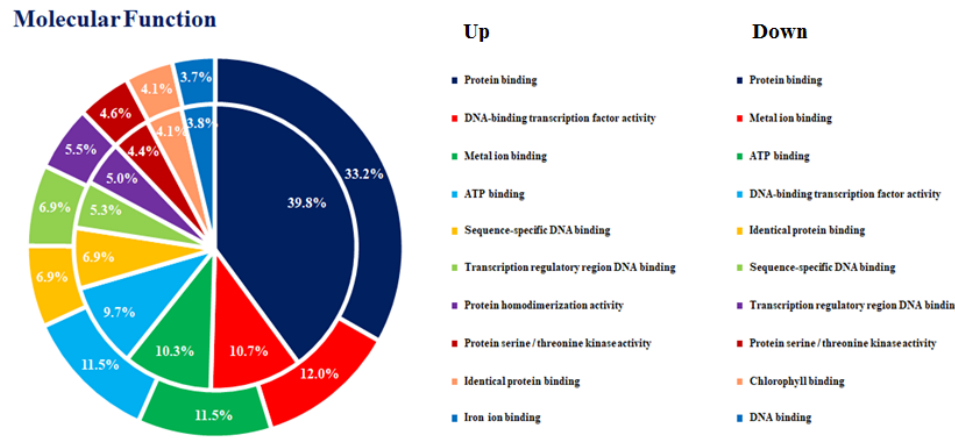
biological process in ethylene-treated ‘Haegeum’ gold kiwifruit.